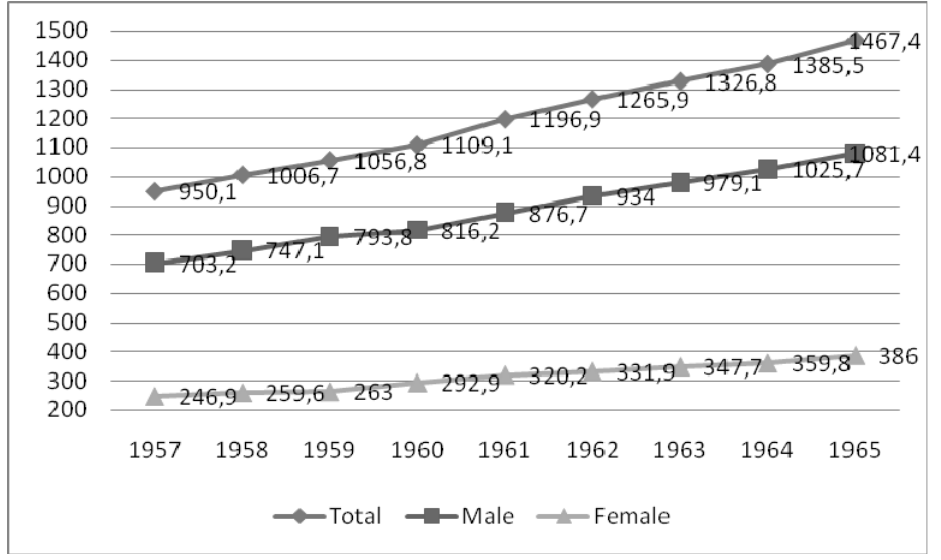
Figure 2. The Dynamics of the Labour Movement in Industry by gender in Romania 1957-1965 (in